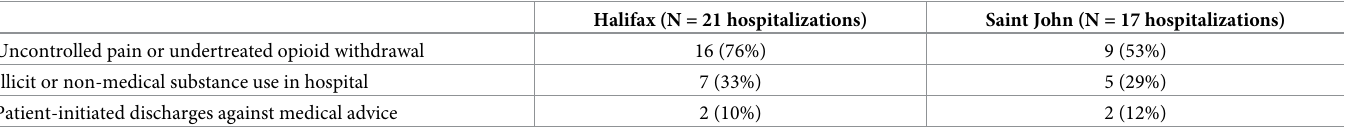
Table 2. Frequency of documentation of potential unmet care needs related to substance use and addiction among patients hospitalized with injection drug use- associated infective endocarditis in Halifax, Nova Scotia and Saint John, New Brunswick,